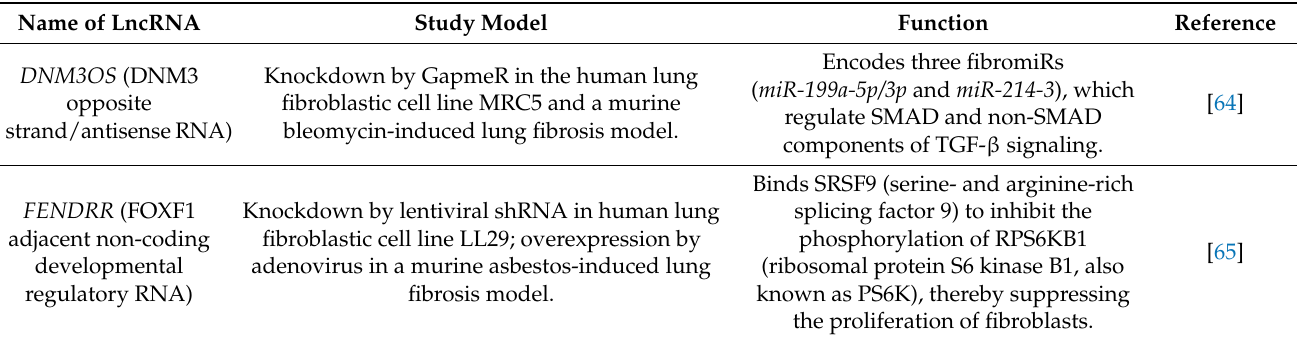
Table 2. List of functionally and mechanistically characterized pulmonary fibrotic